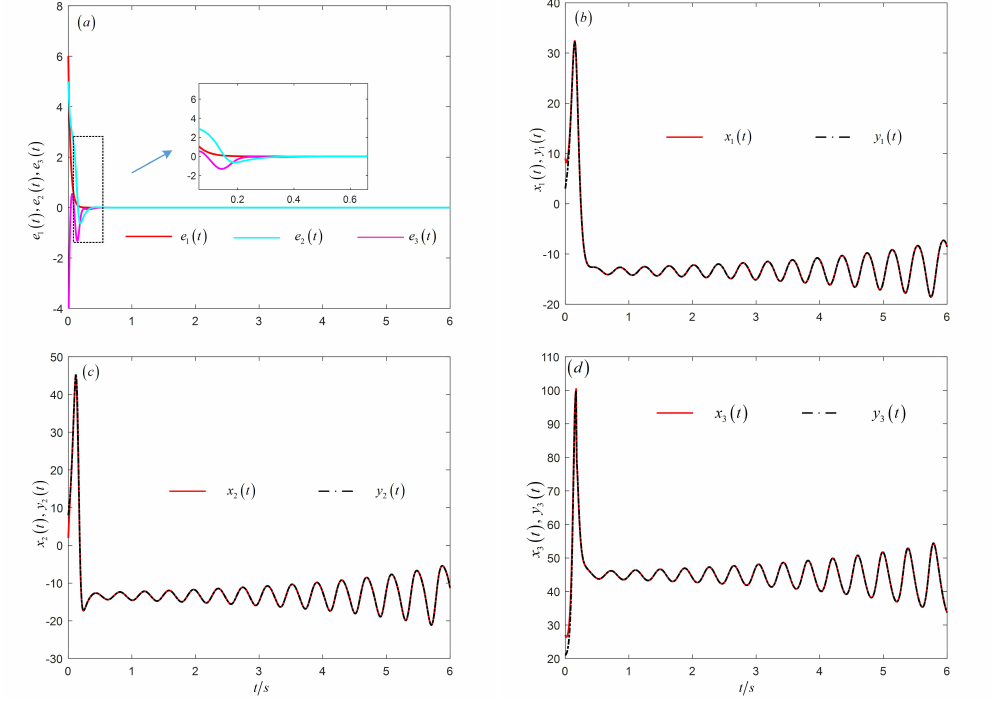
Figure 3. State trajectories of synchronization error vectors ( a ) e 1 , e 2 ,and e 3 , ( b ) x 1 and y 1 , ( c ) x 2 and y 2 , and ( d ) x 3 and y 3